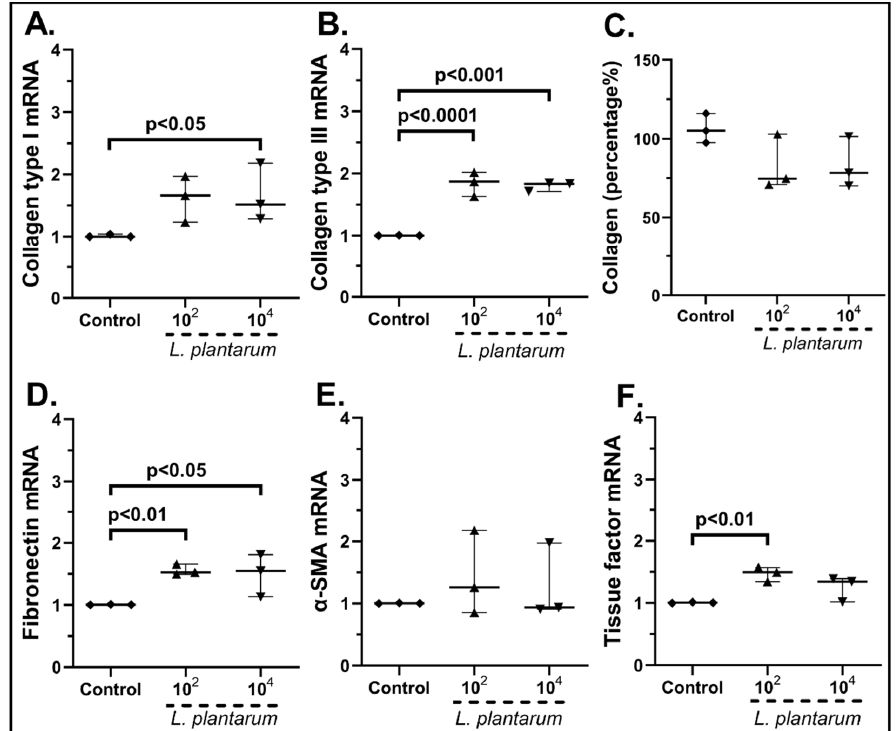
Figure 8. cSEMF mRNA expression of Collagen Type I ( A ), Collagen Type III ( B ), Fibronectin ( D ), α-SMA ( E ), Tissue factor ( F ) and Collagen secretion ( C ) after stimulation with Lactiplantibacillus plantarum. Results are presented as median with interquartile range. N = 3. When cSEMFs were stimulated with Saccharomyces boulardii (Figure 9), the impact was dependent on the concentration of the probiotic. On the one hand, 10 2 cfu/mL of S. boulardii downregulated the mRNAs of Type ΙΙΙ (0.81-fold, IQR: 0.75–0.94, p < 0.05, Figure 9B), but on the other hand its highest dose resulted in a statistically significant increase in its total protein production (205.9%, IQR: 175.7–279.0%, p < 0.001, Figure 9C). In addition, both doses led to the upregulation of Tissue Factor (10 2 cfu/mL: 1.27-fold, IQR: 1.09–1.32, p < 0.01; 10 4 cfu/mL: 1.15-fold, IQR: 1.13–1.20, p < 0.05, Figure 9F), but neither dose had any effect on the mRNA expression of Collagen Type I (Figure 9A), Fibronectin (Figure 9D) and α-SMA (Figure 9E).